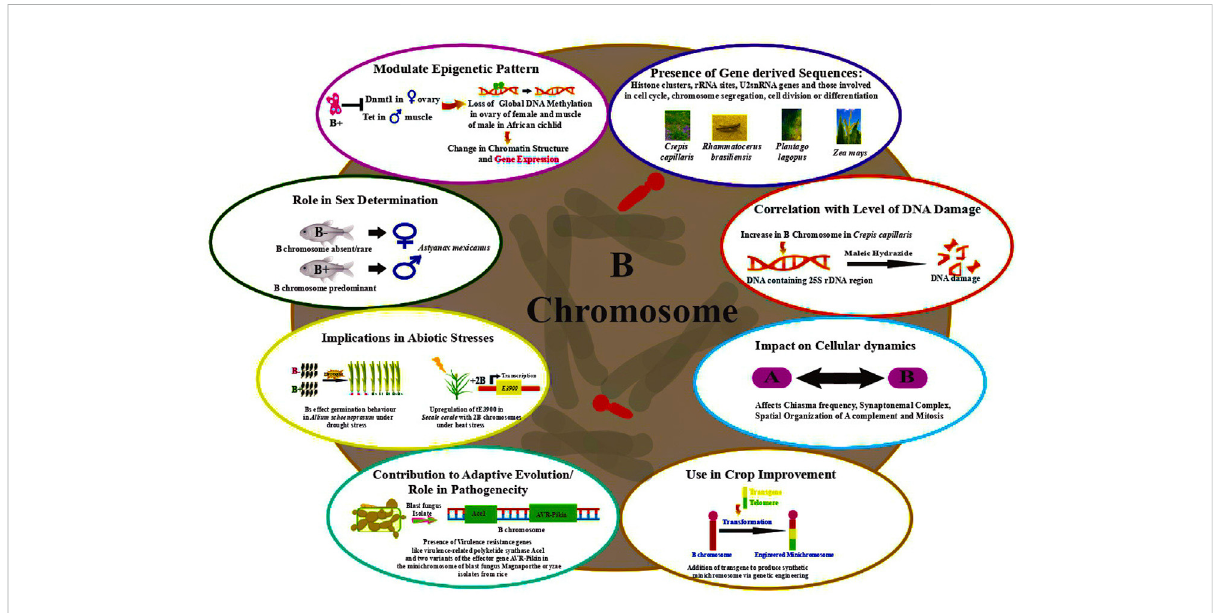
FIGURE 2 Functional aspects of genes identi fi ed on B chromosomes in various